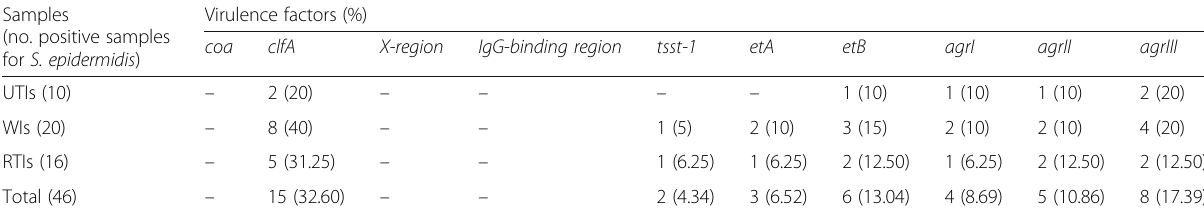
Table 3 Distribution of virulence factors amongst the S. epidermidis strains isolated from different types of hospital infectious samples Samples (no. positive samples for S. epidermidis